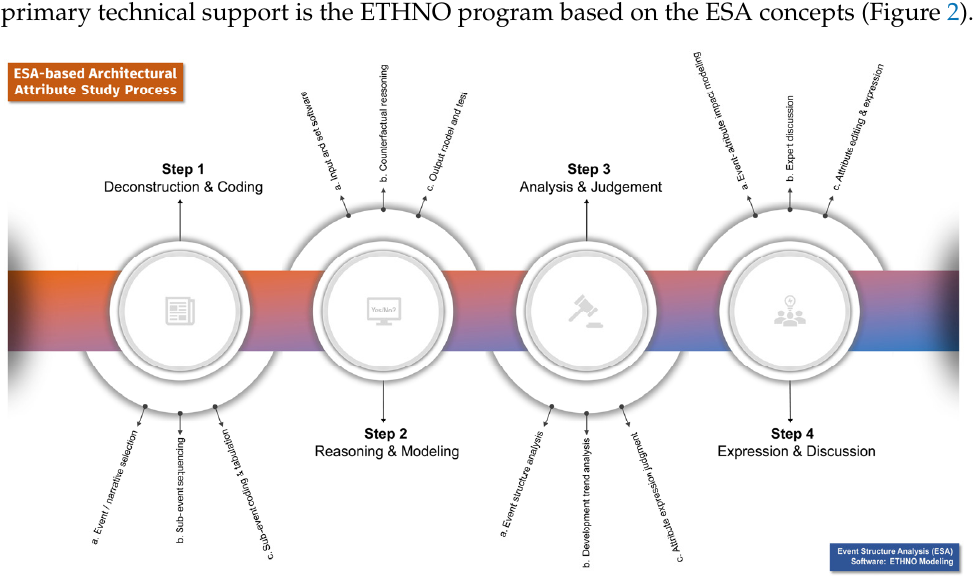
Figure 2. The process of ESA-based attribute study.